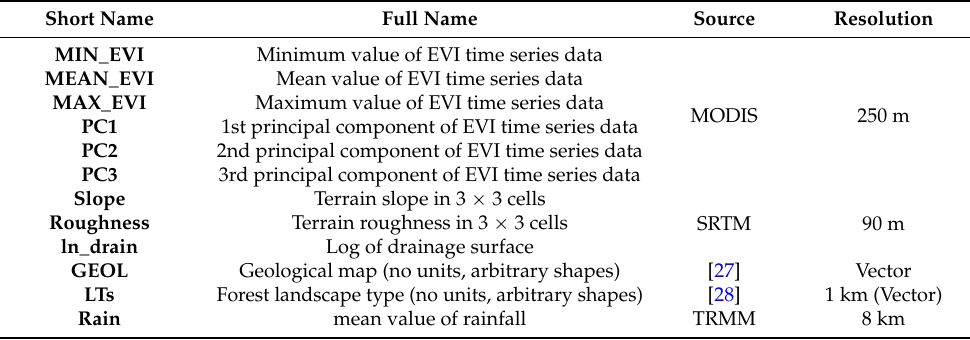
Table 1. Description of the mapped environmental predictors used for canopy height